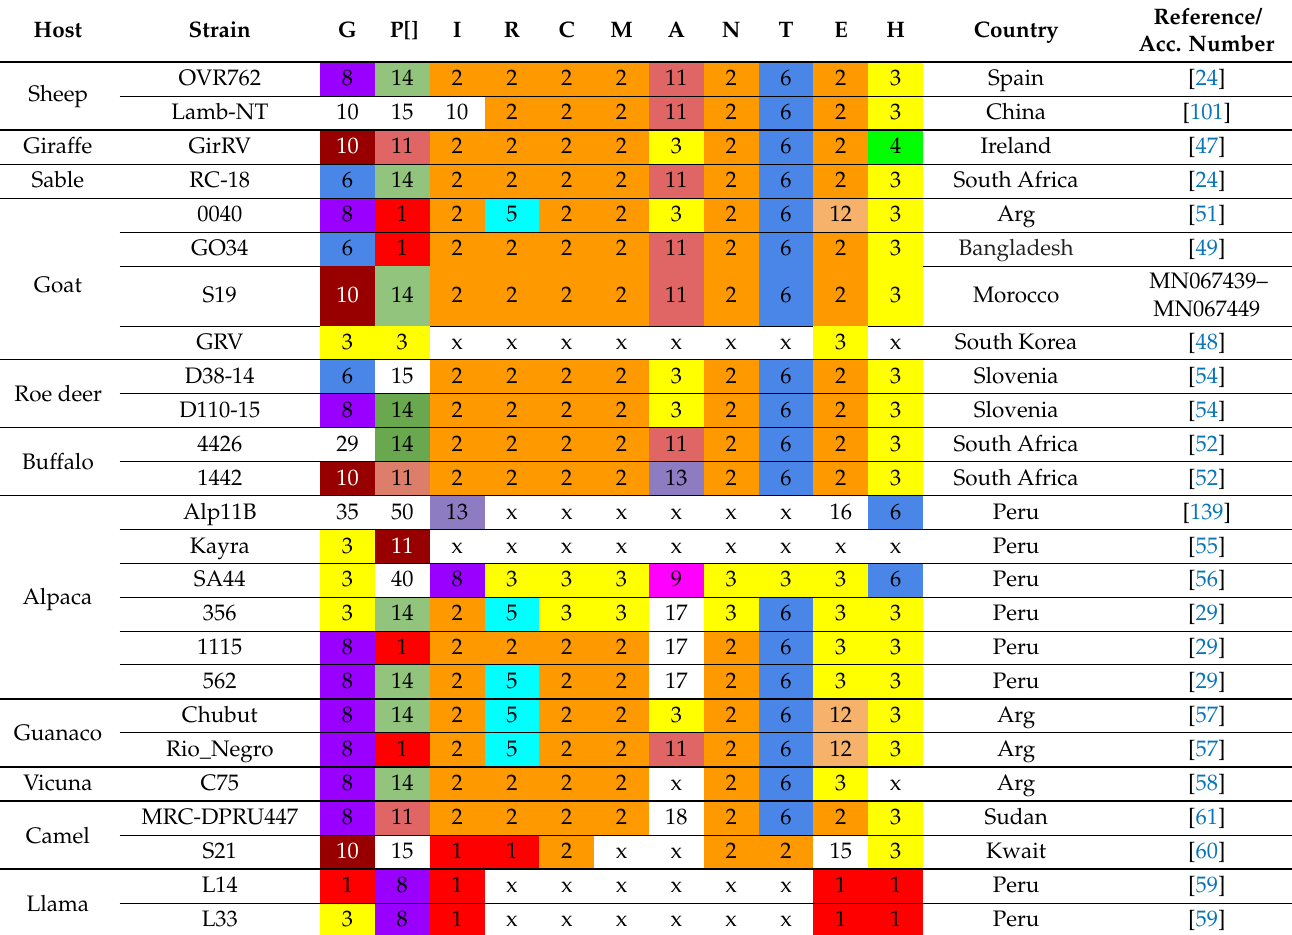
Table A6. Hoofed